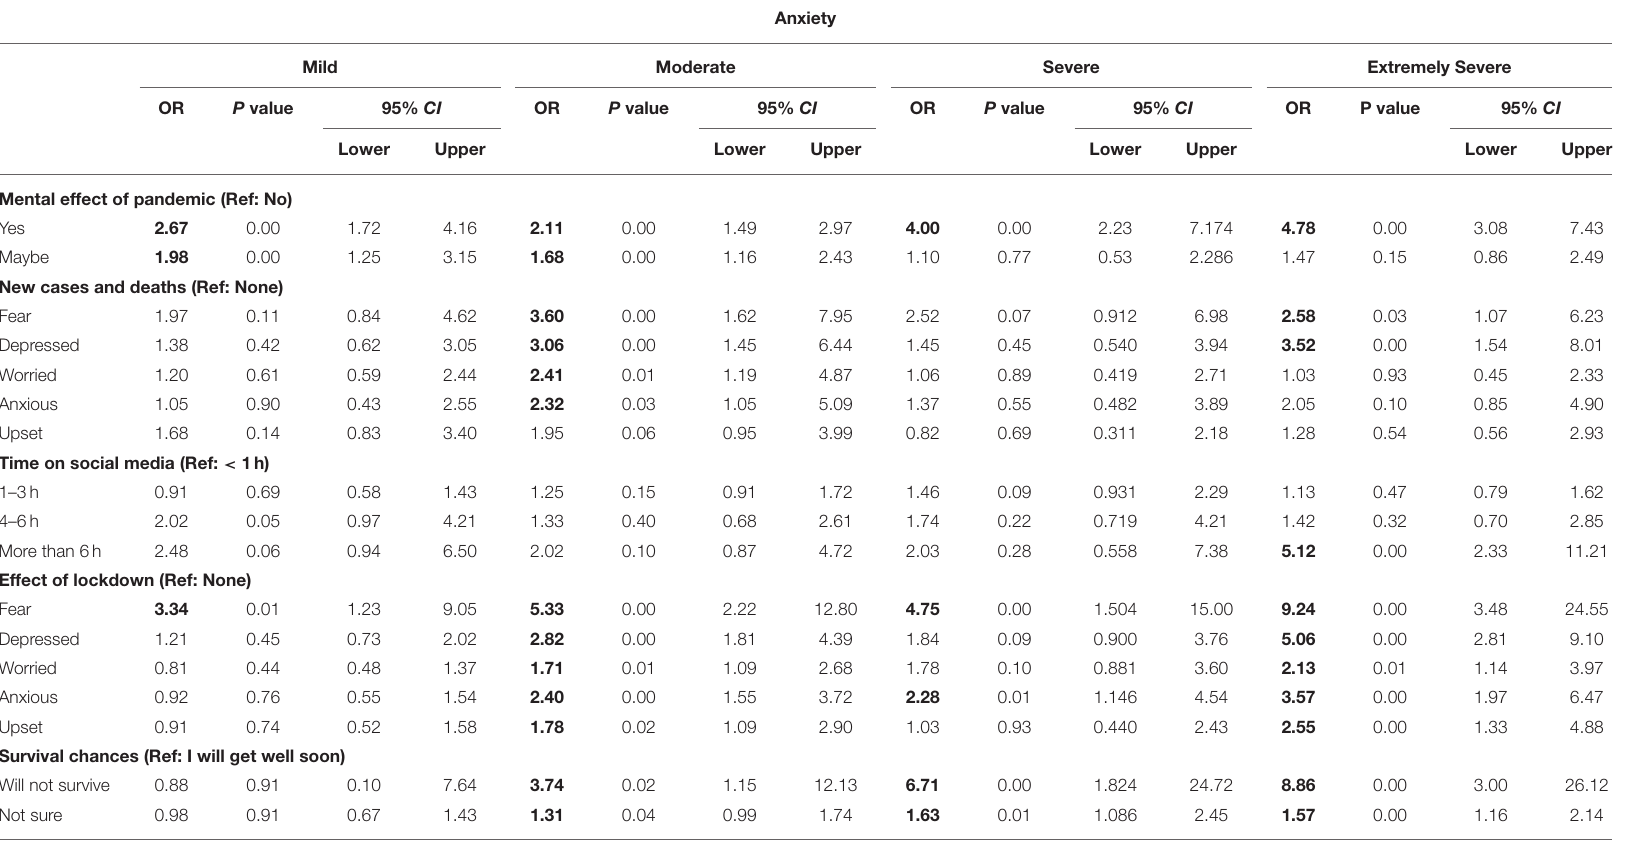
TABLE 4B | Association of level of severity of anxiety with the personal feeling variable identified with multinomial logistic regression. Anxiety Mild Moderate Severe Extremely Severe OR P value 95% CI OR P value 95% CI OR P value 95% CI OR P value 95% CI Lower Upper Lower Upper Lower Upper Lower